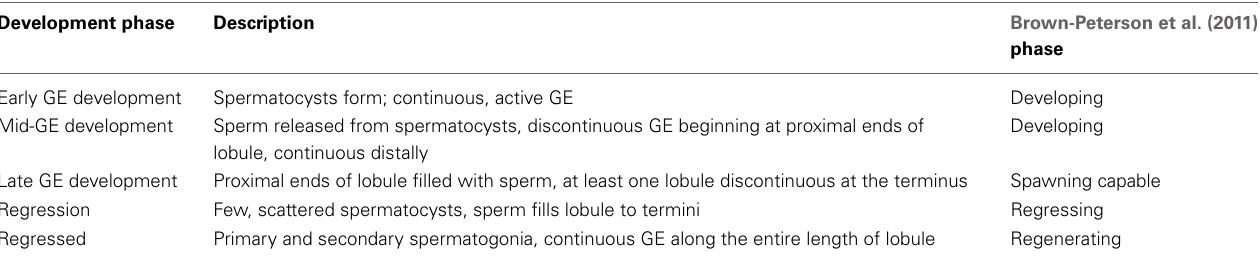
Table 2 | Maturation phases for histological analysis of male fish based on the activity of the germinal epithelium (GE) and the development of germ cells, with terms and phases based on Grier and Taylor (1998).